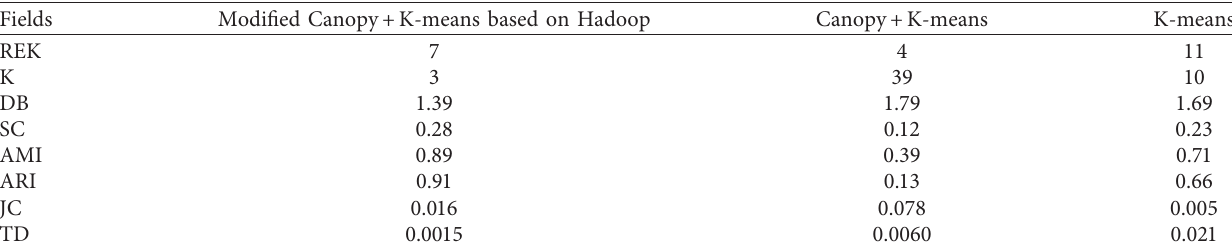
Table 3: Evaluation of clustering effect when setting the number of K-means clusters to